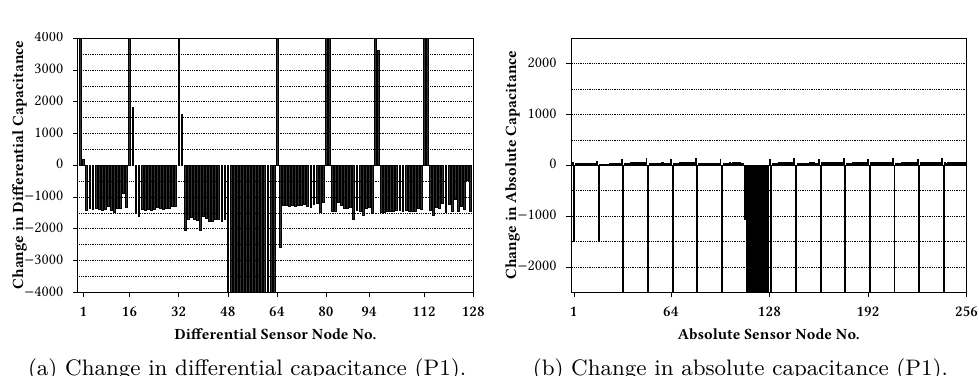
Figure 17: Attack Profile 1 (P1): result of a single hole of 0 . 3 mm in diameter, severing electrode Tx8 and Rx2. Clearly visible is the significant change in values.